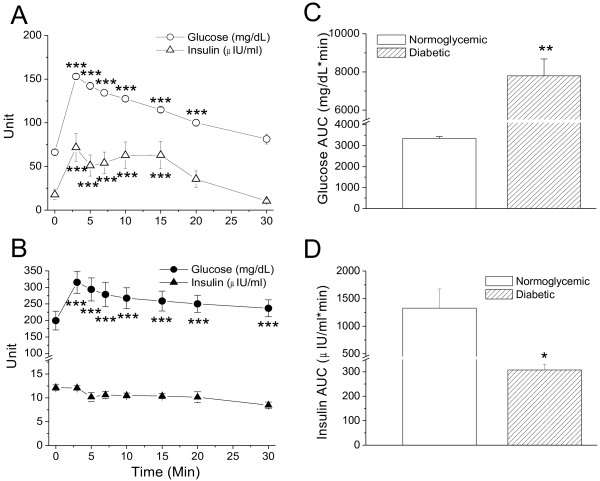
Intravenous glucose tolerance test (ivGTT) in normoglycemic and insulin-dependent diabetic cynomolgus monkeys (Table1). Plasma glucose and insulin levels were measured at the scheduled time points in normoglycemic (panel A, n = 5) and insulin-dependent diabetic (panel B, n = 5) monkeys. Panel C shows the glucose AUCs of the ivGTTs for the nomorglycemic (blank bar) and diabetic (strip bar) monkeys. Panel D shows the insulin AUCs of the ivGTTs for the normoglycemic (blank bar) and diabetic (strip bar) monkeys. *, p < 0.05; **, p < 0.01, ***, p < 0.001; vs. the level at time zero or vs. the normoglycemic group.